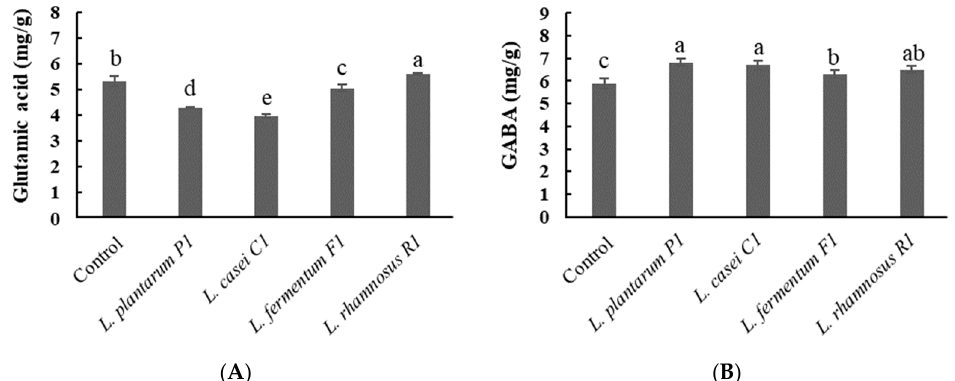
Figure 2. Glutamic acid ( A ) and GABA ( B ) contents of Oryza sativa extracts depending on the Lactobacillus strains. Each bar is the mean ± standard deviation of the results from three different analyses ( n = 3). The bars with different letters (a–e) indicate significant differences at p < 0.05 using Duncan’s multiple range test.